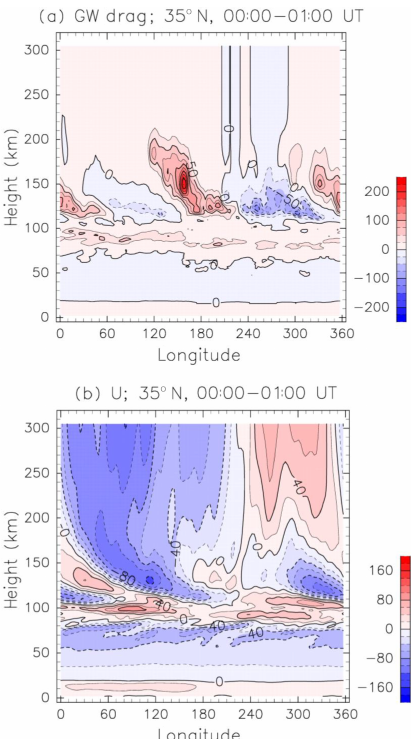
Figure 7. (a) Height–latitude section of the zonal mean of the zonal GW drag in June obtained by EXP1. Positive and negative values are eastward and westward acceleration, respectively. Units are me- ters per second per day. (b) As in (a) except for EXP2.